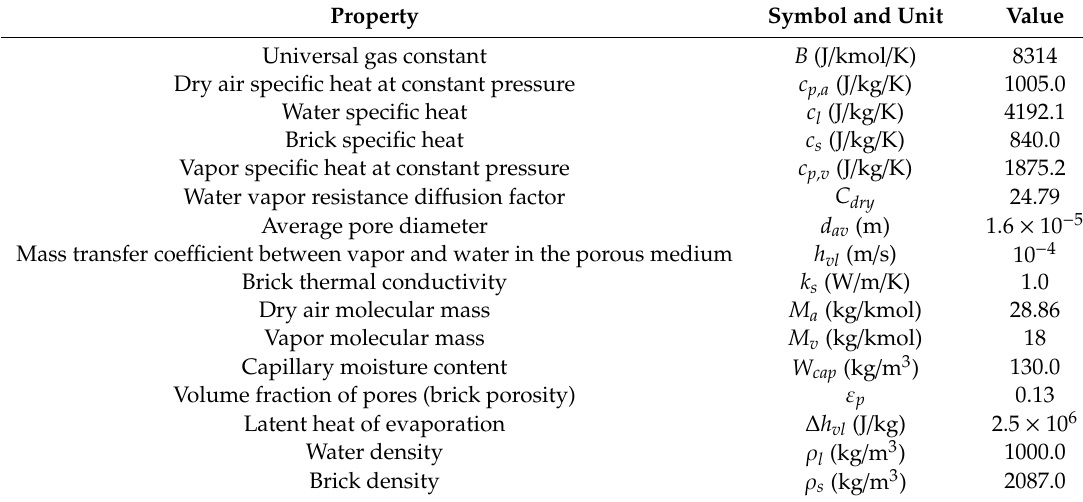
Table 1. Thermophysical properties assumed during simulations [17].